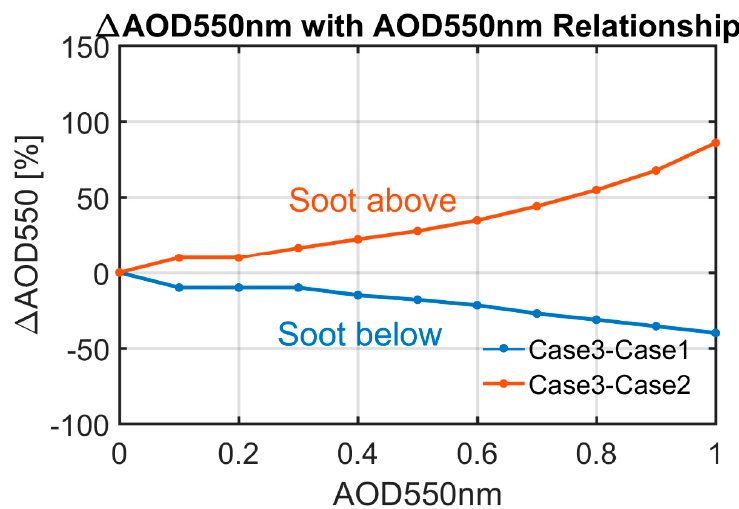
Figure 11. Relative errors of AOD 550 nm by ignoring the different vertical distribution of absorbing and scattering aerosols. (Case 1: soot lying between 0–1.0 km, sulfate lying between 3.0–4.0 km; Case 2: the reversed structure with case; Case 3: a mixed exponential profile).